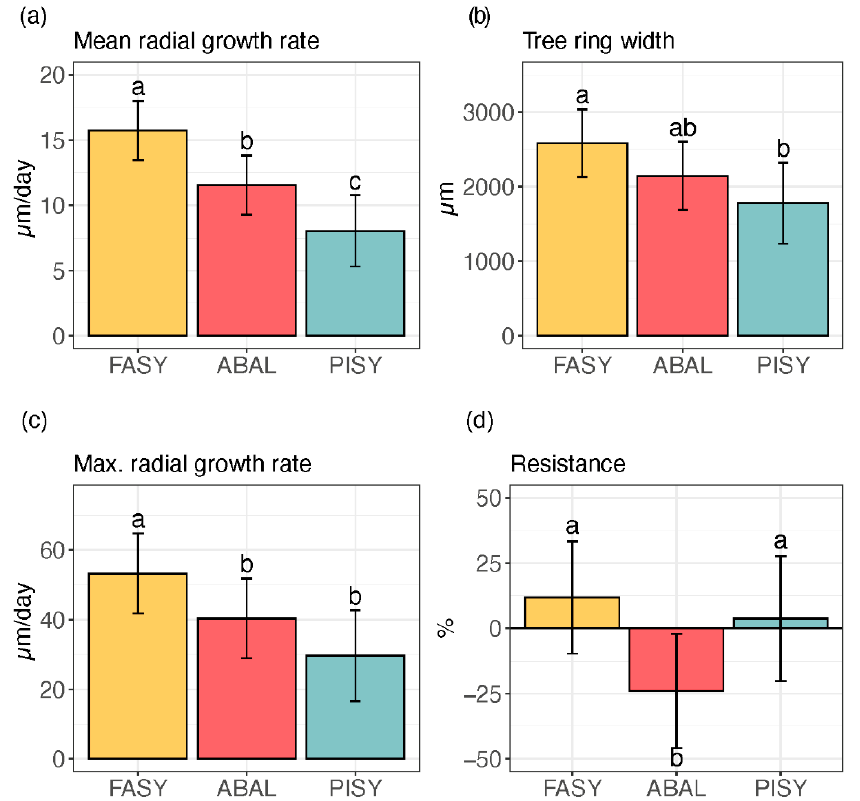
Figure 6. Estimated marginal means of the xylem growth per species (mean daily radial growth rate) ( a ), tree-ring width ( b ); maximum daily radial growth rate ( c ), and the difference between 5-year mean tree-ring width before 2018 and tree-ring width of 2018 ( d ); FASY: Fagus sylvatica , ABAL: Abies alba , PISY: Pinus sylvestris ). Error bars indicate 95% confidence levels of estimated marginal means. Different lowercase letters indicate significant differences of the sample means between the tree species ( p < 0.05).